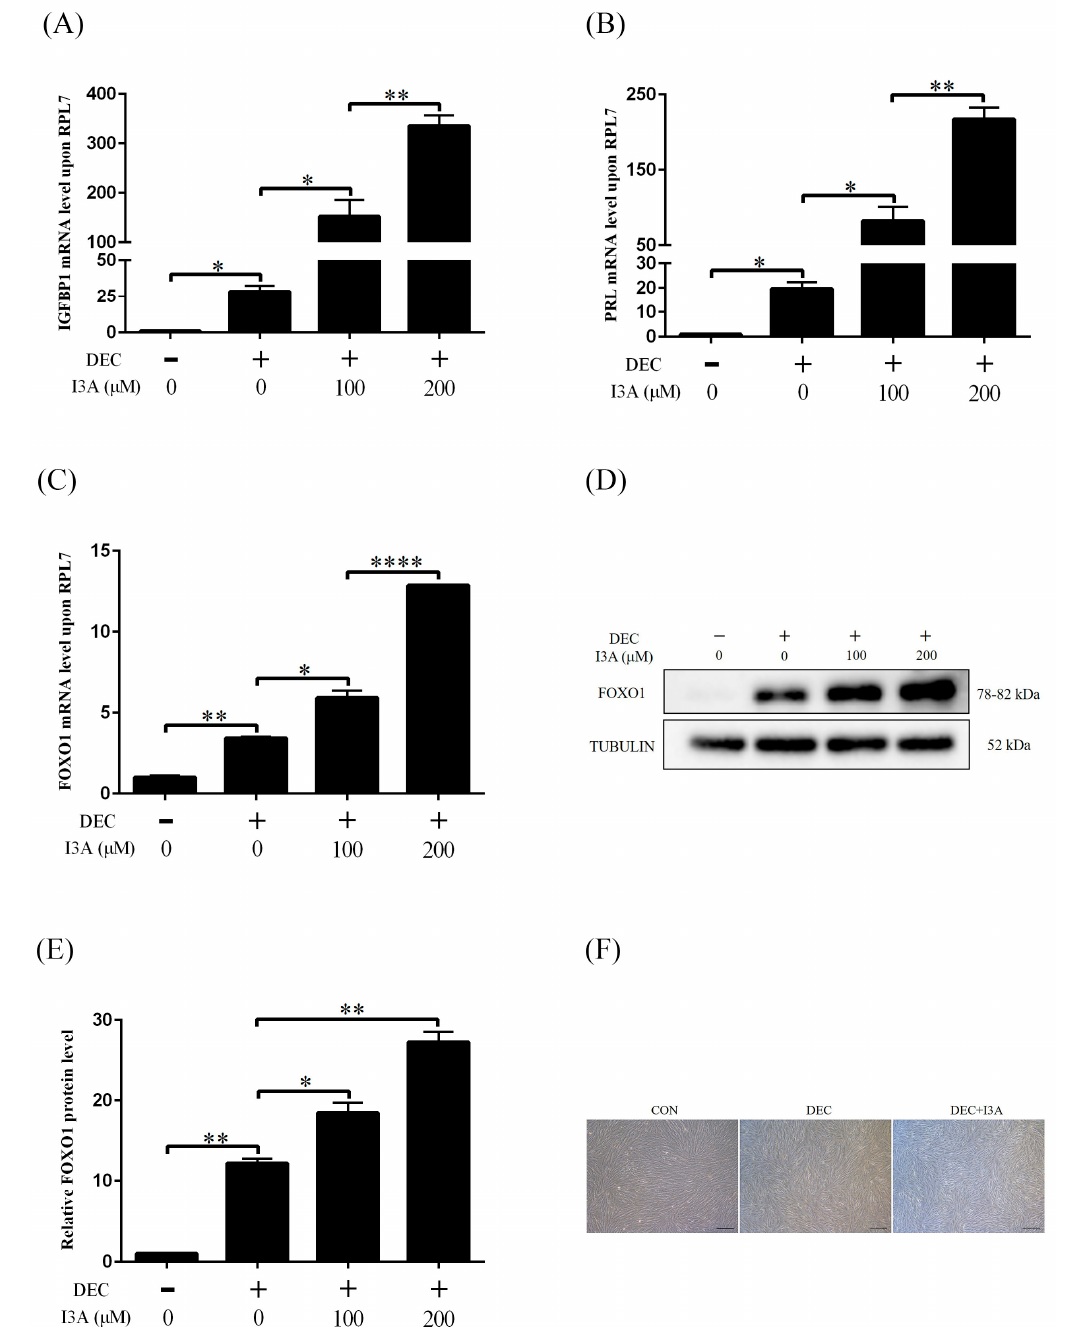
Figure 3. The effects of I3A on human in vitro decidualization. ( A ) RT-qPCR analysis on effects of different concentrations of I3A on IGFBP1 mRNA level under in vitro decidualization for 4 days. ( B ) The effects of different concentrations of I3A on PRL mRNA level under in vitro decidualization for 4 days. ( C ) Effects of different concentrations of I3A on FOXO1 mRNA level under in vitro decidualization for 4 days. ( D , E ) Western blot analysis of the protein level of FOXO1. ( F ) Effects of 200 µ M I3A on the morphology of human endometrial stromal cells under in vitro decidualization for 4 days. Scale bar = 20 µ m. CON, control. DEC, decidualization; I3A, indole-3-aldehyde. *, p < 0.05; **, p < 0.01; ****, p <